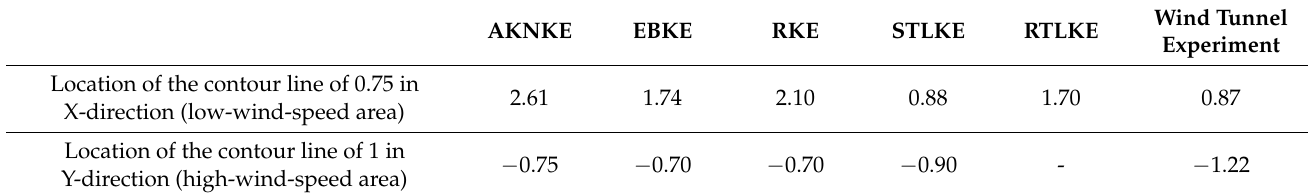
Figure 17. Contour plots of turbulent kinetic energy at z/b = 1.25. Table 14. Location of contour line at z/b = 1.25 (turbulent kinetic energy).